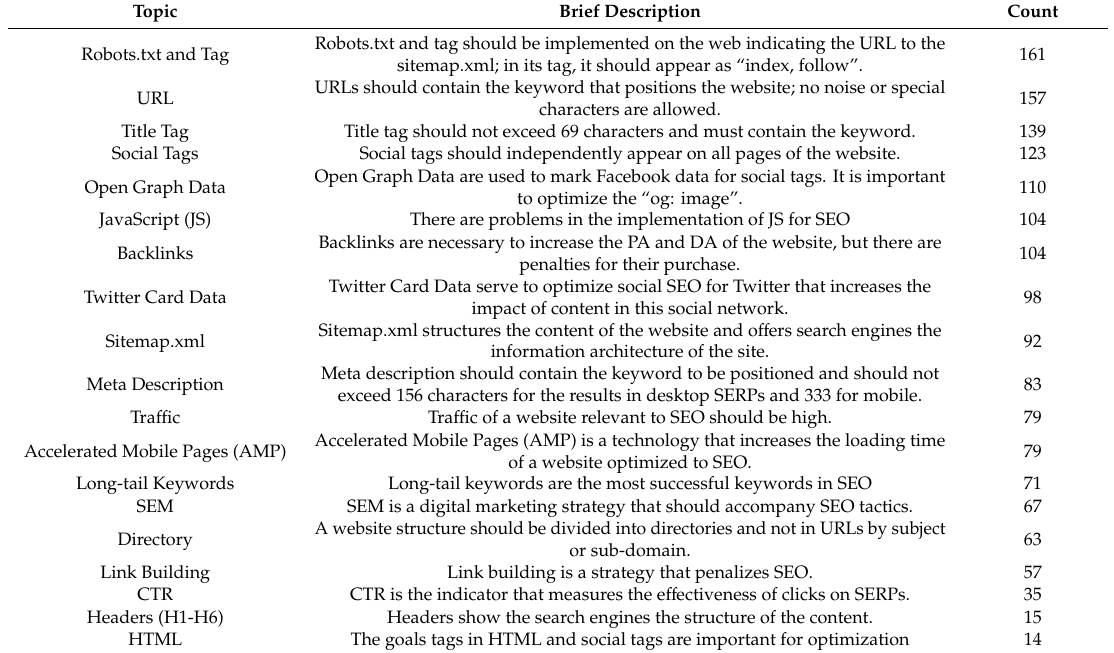
Table 1. Latent Dirichlet allocation (LDA) topics identification of Search Engine Optimization (SEO) indicators for